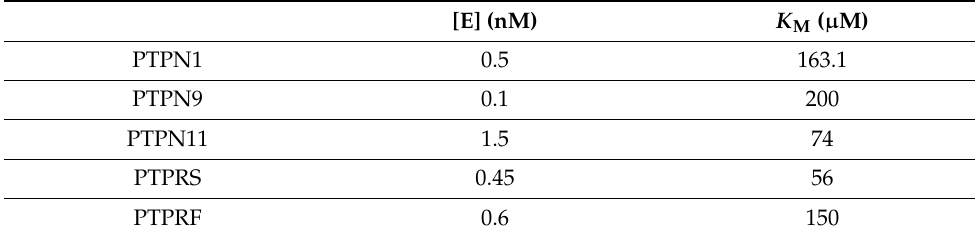
Table 2. Kinetic constants for DiFMUP hydrolysis by